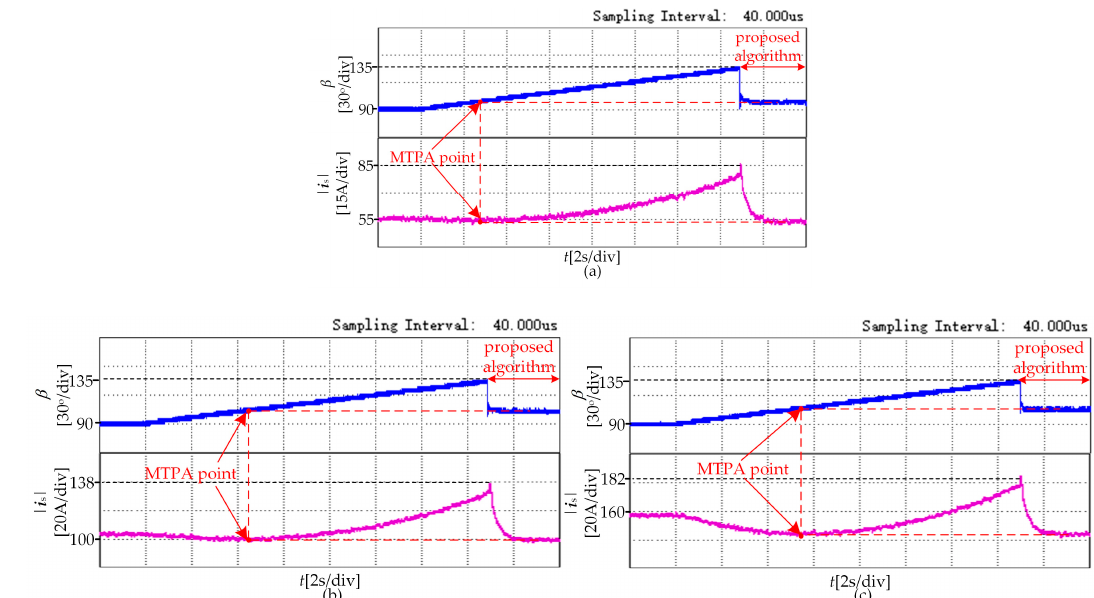
Figure 9. The experimental waveforms of MTPA control under different loads: ( a ) load for 20N·m, · m, ( c ) load for 60N · ( b ) load for 40N·m, ( c ) load for 60N·m. ( b ) load for 40N